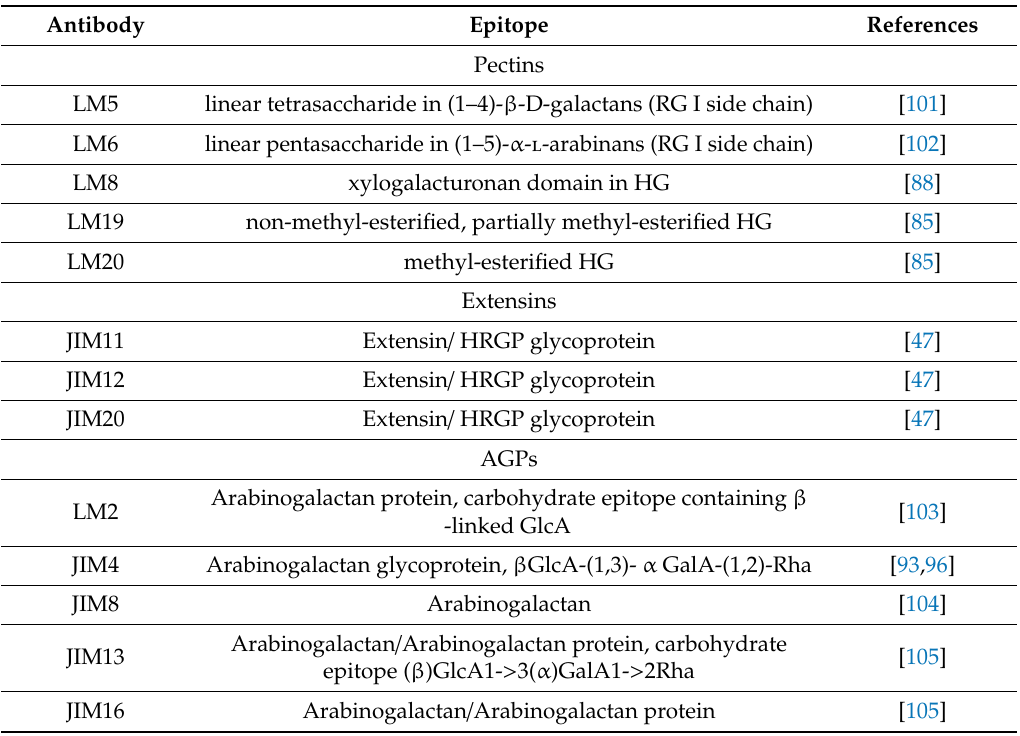
Table 2. List of the primary rat monoclonal antibodies that were used in the current study. Antibody